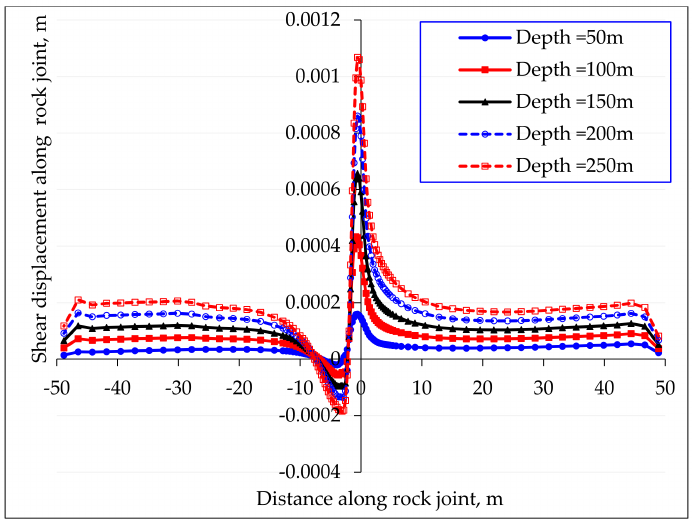
Figure 25. Shear displacement along a rock yielded joint that runs beneath the tunnel opening at different tunnel depth below